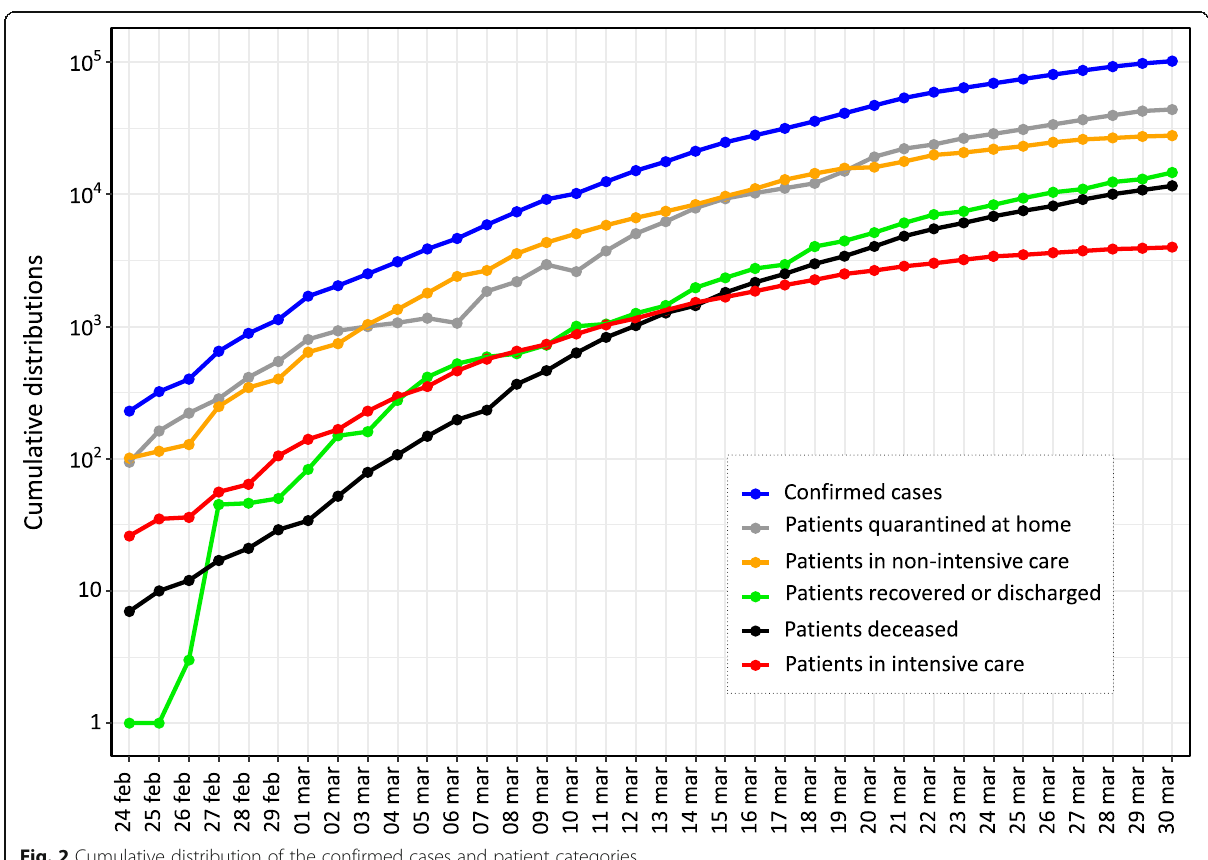
Fig. 2 Cumulative distribution of the confirmed cases and patient categories